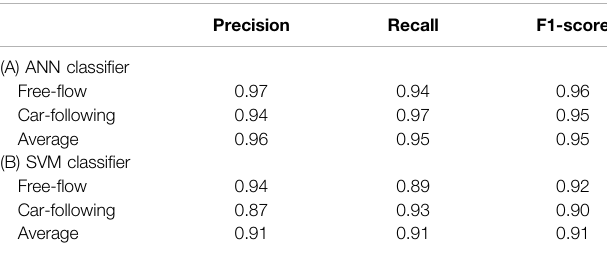
TABLE 1 | Classifying Humans ’ Free- fl ow and Car-following Braking Behavior using Summarized Time Series: (A) ANN, and (B) SVM. Precision